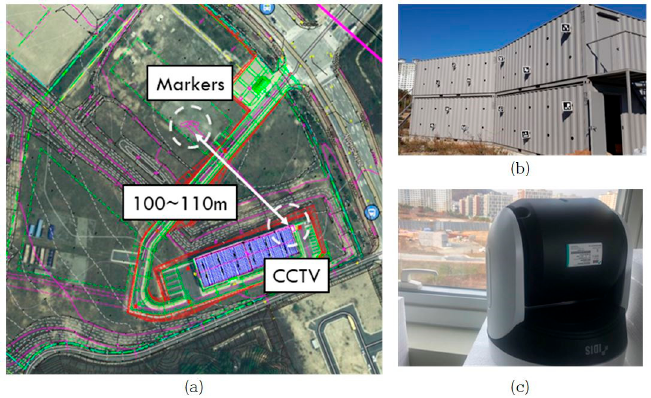
Figure 7. Experimental setup: ( a ) location of markers and closed circuit television (CCTV); ( b ) markers on the container; ( c ) CCTV in the building.